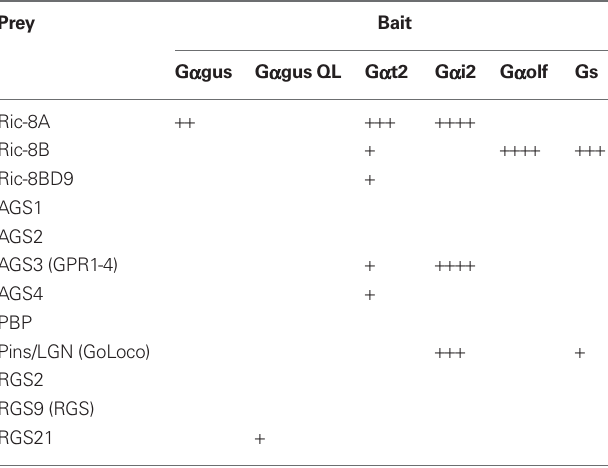
Interaction between various modulators of G-protein signaling and G-protein alpha subunits was tested using the Proquest yeast two-hybrid system. Interaction was scored on minimal medium plates containing 25 mM 3-AT and lacking leucine histidine and tryptophan. Growth represented by stars in the table refl ects the strength of the interaction. + weak, ++ moderate, +++ strong, ++++ very strong. Note that AGS3 and PBP interact strongly with G α i2 as previously reported (Bernard et al., 2001) however except for Ric-8A none of the proteins tested interacts with gustducin under these